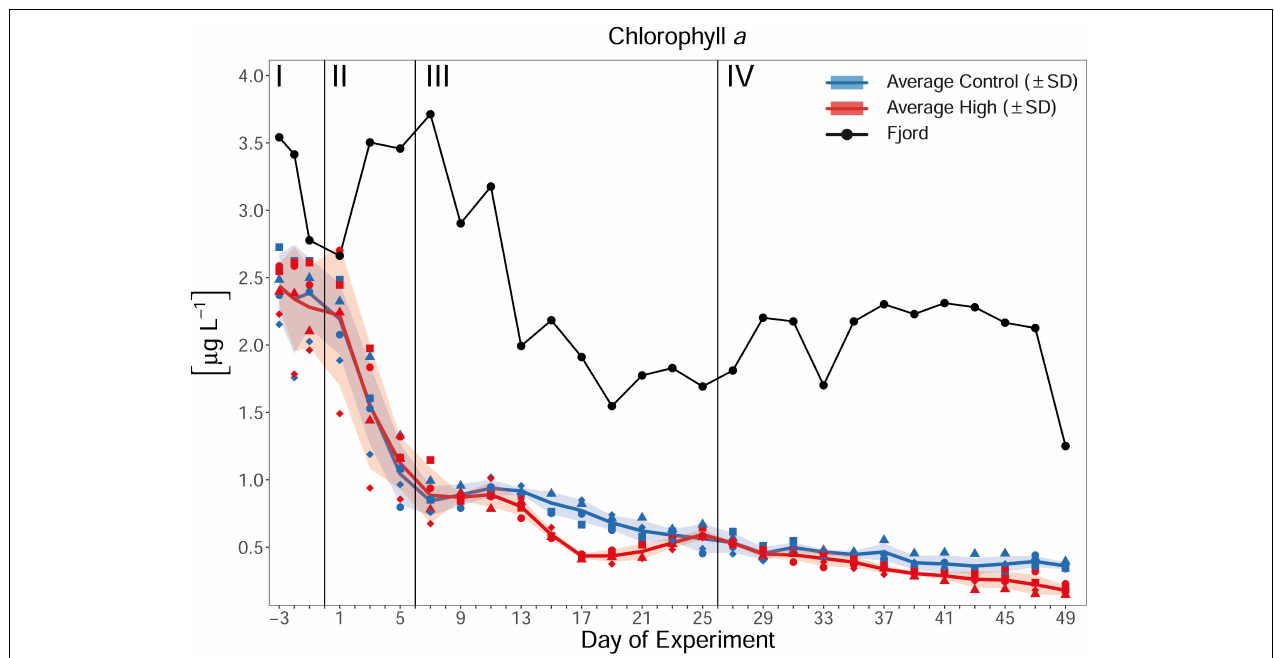
FIGURE 4 | Temporal development of average chl a concentration over the course of the experiment. Blue, red, and black line indicate the respective average concentration in the control, high p CO 2 treatment, and the Fjord. The ribbons represent the standard deviations (SD). Blue symbols represent concentrations in the ambient p CO 2 mesocosms (M1, M2, M4, and M7), red symbols in the high p CO 2 mesocosms (M3, M5, M6, and M8), black symbols represent the fjord. For assignment of symbols to the individual mesocosms see Table 1 . Roman numerals indicate the different phases of the experiment separated by vertical lines (for description of phases see Table 2 ). Figure created with the ggplot2 package in RStudio (Rstudio Team, 2016; Wickham et al.,